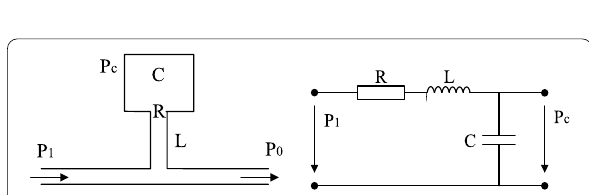
Figure 24 Electrical schematic diagram of H-type pulsation